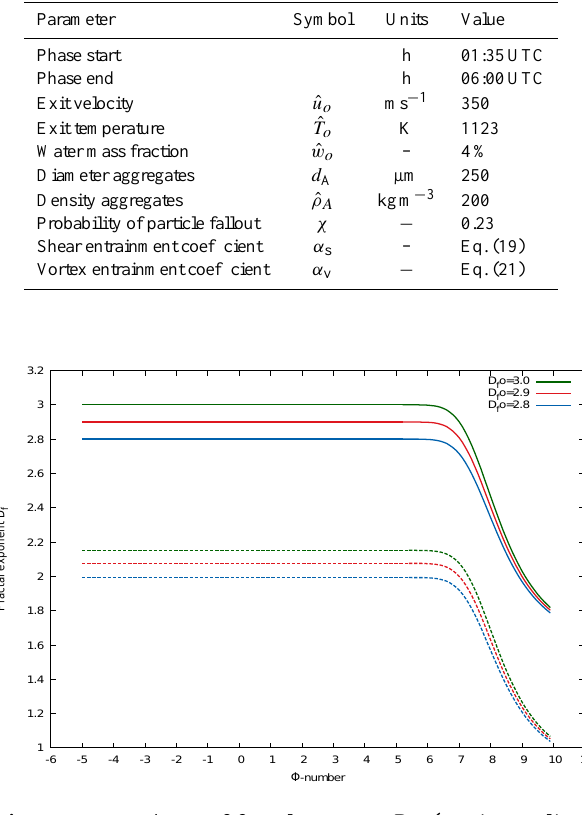
(a.s.l.), a mass eruption rate of 2 . 7 × 10 8 kgs − 1 and a total